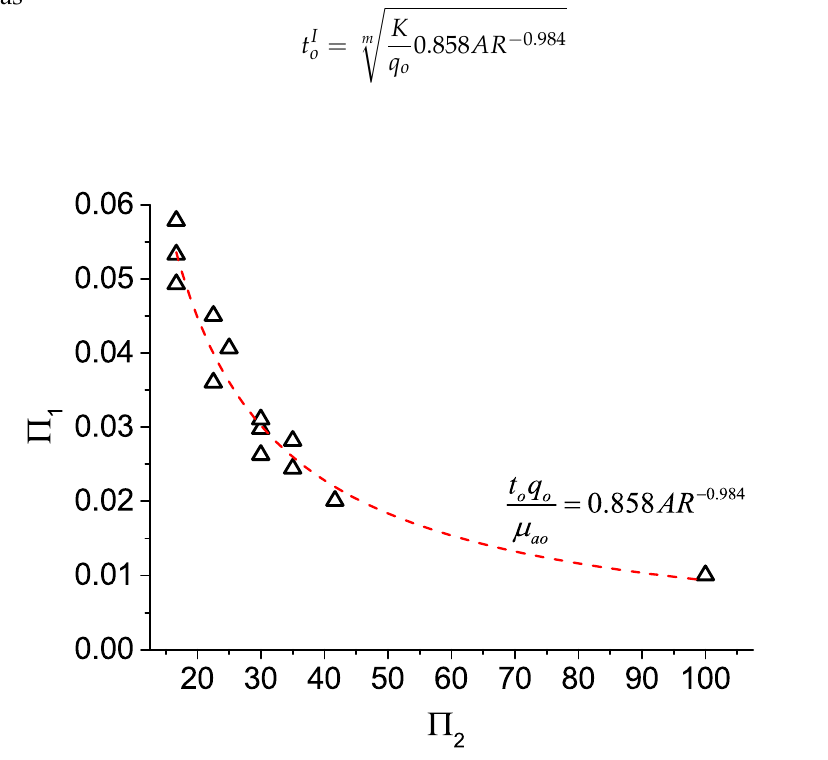
Figure 2. Π 1 vs. Π 2 . For each material and temperature, a mean value of Π 1 is plotted. Fitting power function is added.